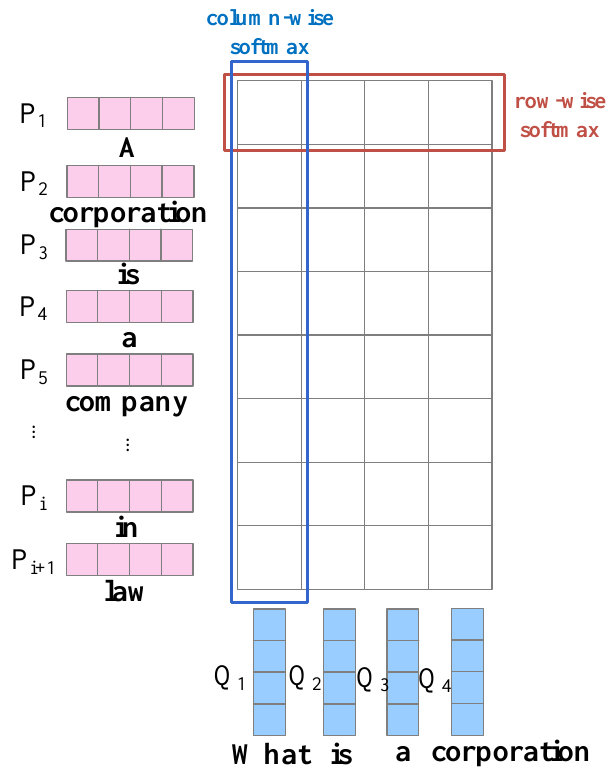
Figure 12. Using bidirectional attention to mine correlation between the context and